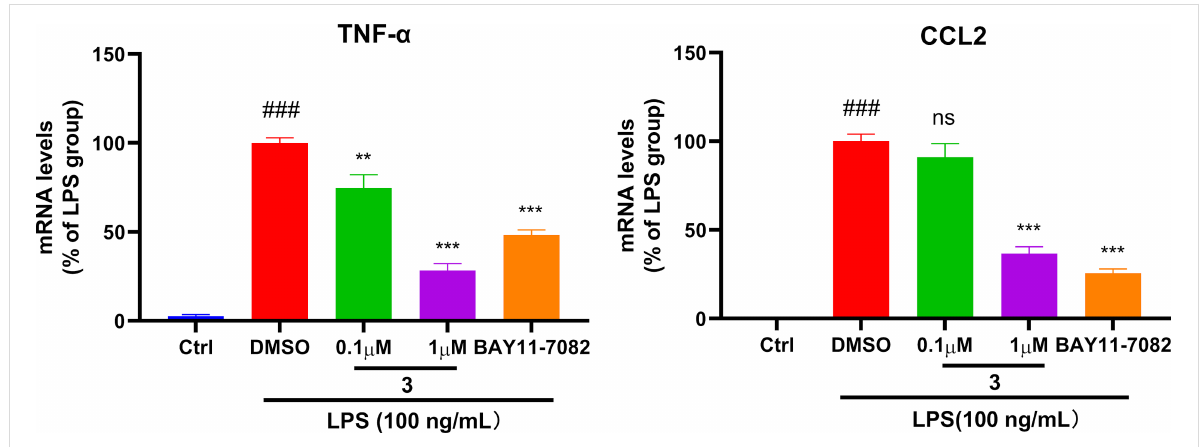
Figure 6: Compound 3 reduced the mRNA levels of TNF- α (left) and CCL2 (right) in LPS-stimulated RAW264.7 macrophages. Data were normalized by DMSO group and are presented as means ± standard errors of the mean ( n = 3). ### p < 0.001 vs the control group; *** p < 0.001 vs the DMSO